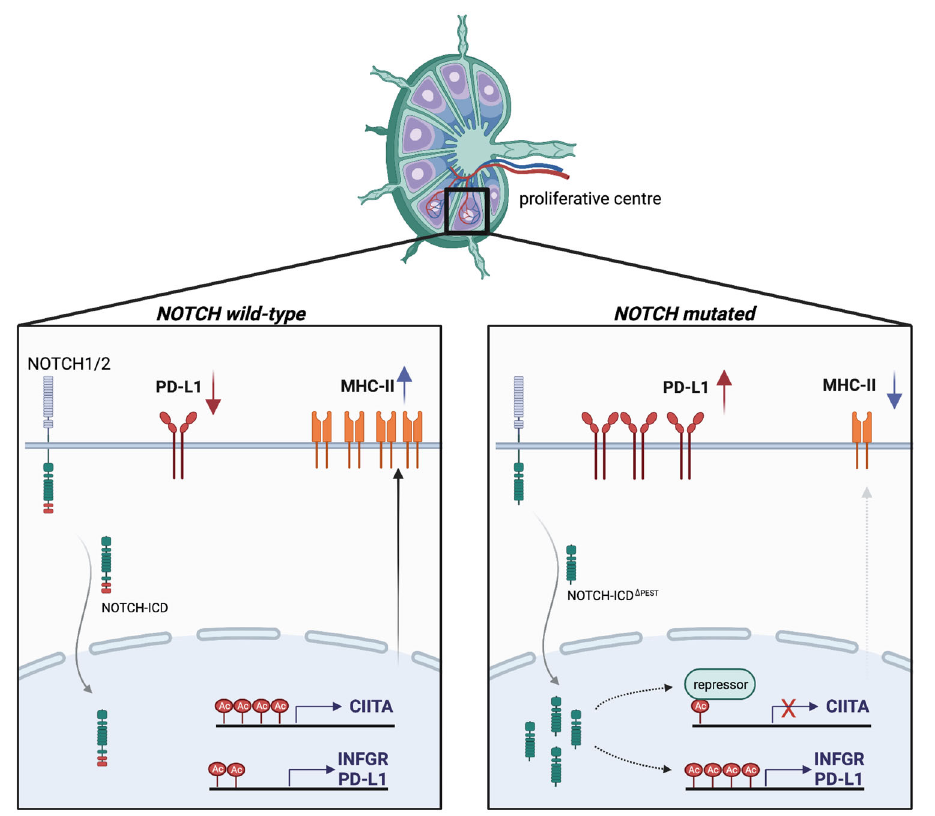
Fig.8|Graphicalsummary. Leftpanel:Intheabsenceof NOTCH mutations,tumor B cells in proliferative centers constitutively express MHC class II and PD-L1 on their cell surface. Right panel: Mutations in the PEST domain of NOTCH1 or NOTCH2 cause higher NOTCH levels and transcriptional activity, which leads to a